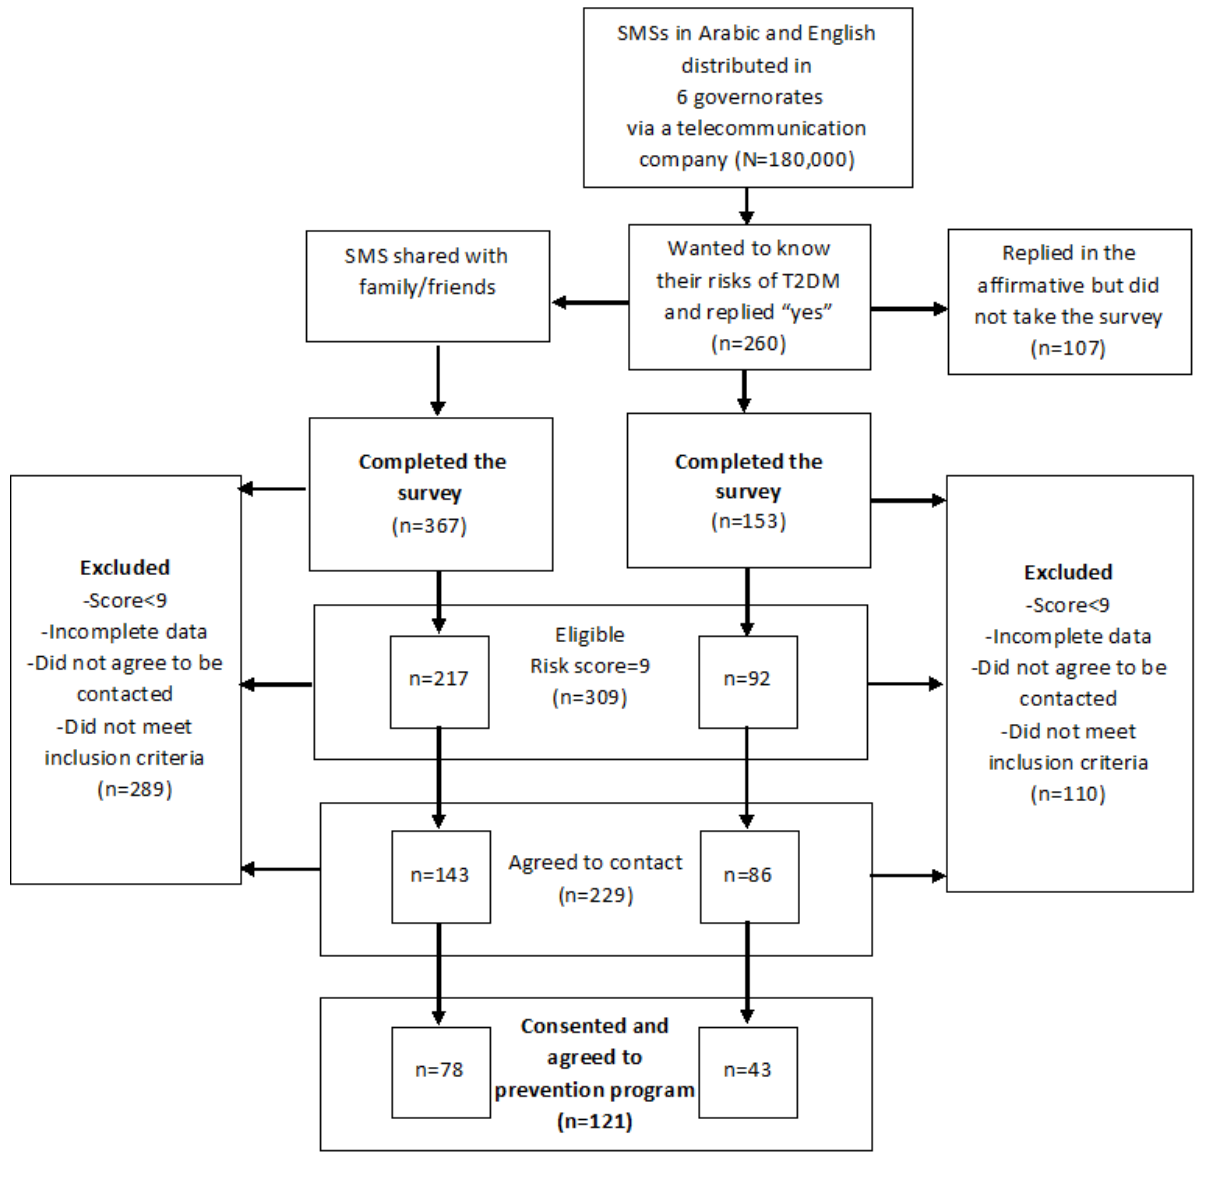
Table 1. Details of respondents for the 5 SMS campaigns originally circulated in 6 governorates in Kuwait between 2017 and 2018.